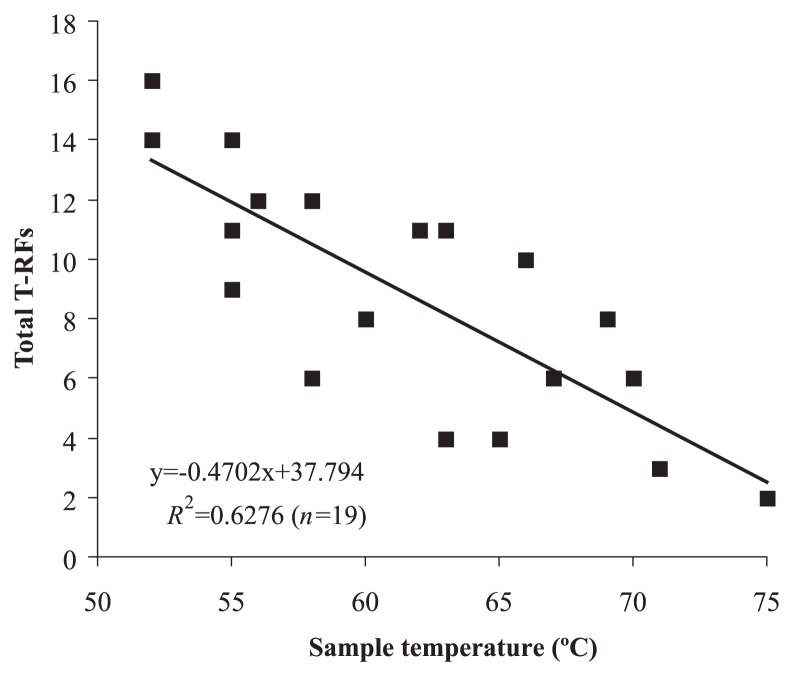
Regression between temperature and total number of T-RFs for each sample collected. T-RF signals were normalized by sample to the lowest sample value to correct for variations in loading between samples and for an unbiased estimate of richness. Temperature has a significant effect on the number of T-RFs observed (R2=0.6276, t=6.97 (17); P<0.0001). Raw values also showed a similar relationship, but with a lower R2 value (0.39).